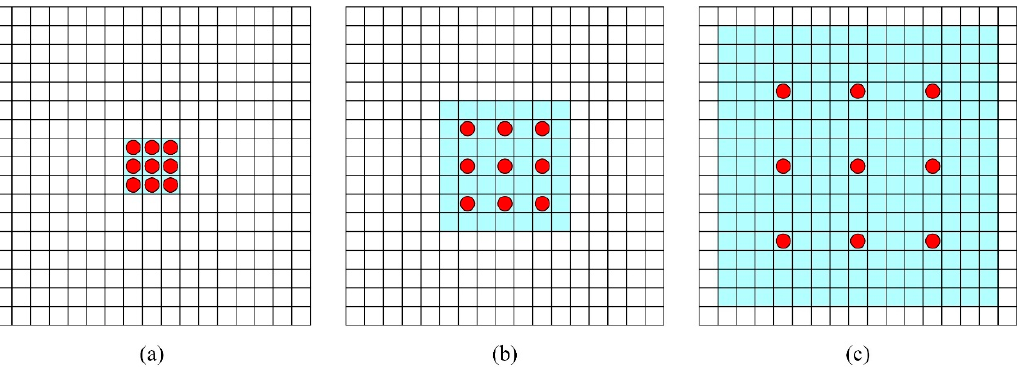
Figure 3. Dilated Convolution layer with different dilation rates. ( a ) Kernel size of Dilated Convo- lution is 3 × 3 and dilation rate is 1, which is same as the normal convolution process. ( b ) 2-dilated conv with kernel size is 3 × 3 and zero padding; ( c ) 4-dilated